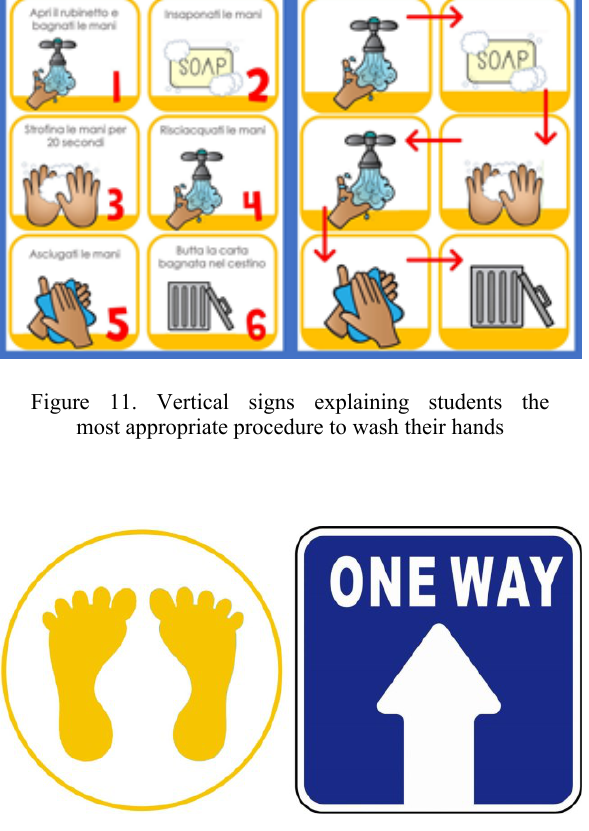
Figure 12. Horizontal signs explaining the waiting point and